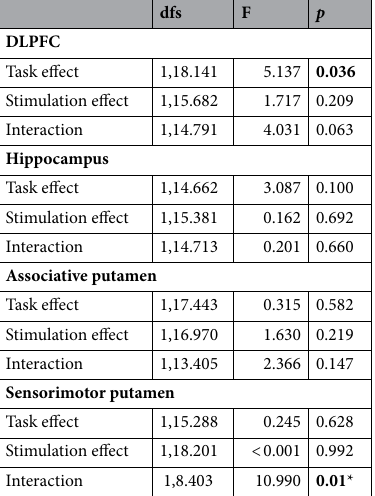
Table 1. Task by stimulation effects on pattern similarity between early and late task practice stages controlling for the visit effect. Bold values indicate p < 0.05. False-discovery-rate (FDR) correction for multiple comparisons (4 ROIs) was applied with the Benjamini–Hochberg procedure 61 . *indicates significance at